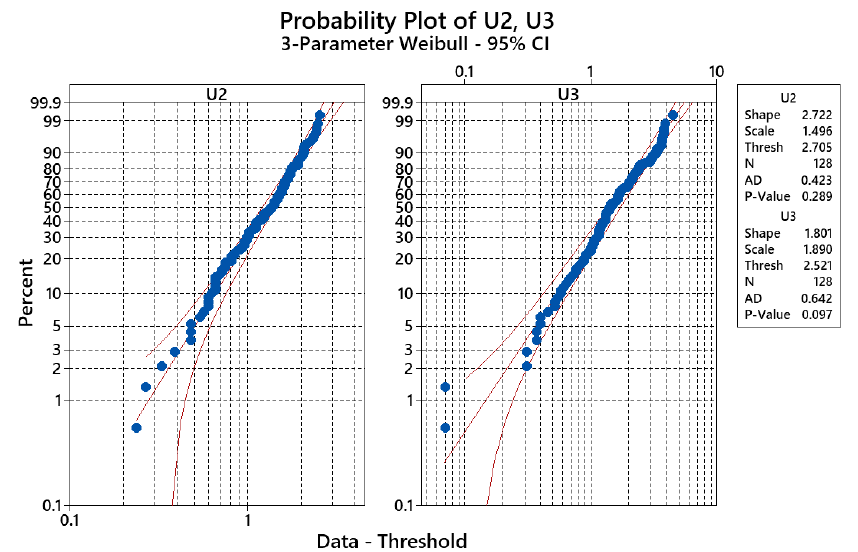
Figure 8. Probability plot of the validity of proposed model for the response of 𝑢 (cid:2870) and 𝑢 (cid:2871) .